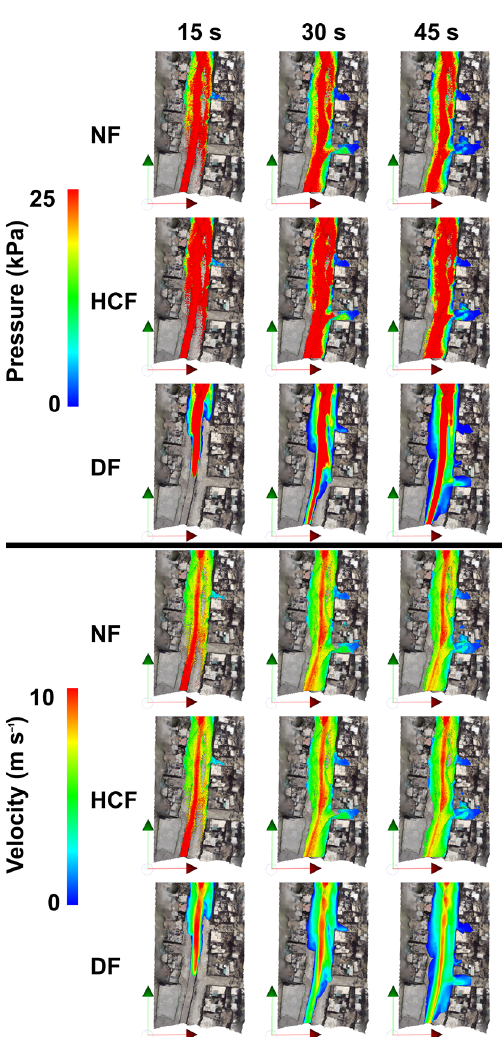
Figure 5. Evolution of dynamic pressure and velocity magnitudes for a 75m 3 s − 1 flow along Quebrada Dahlia for a Newtonian flow (NF), hyperconcentrated flow (HCF) and debris flow (DF). Arrows indicate northerly (green) and easterly (red)